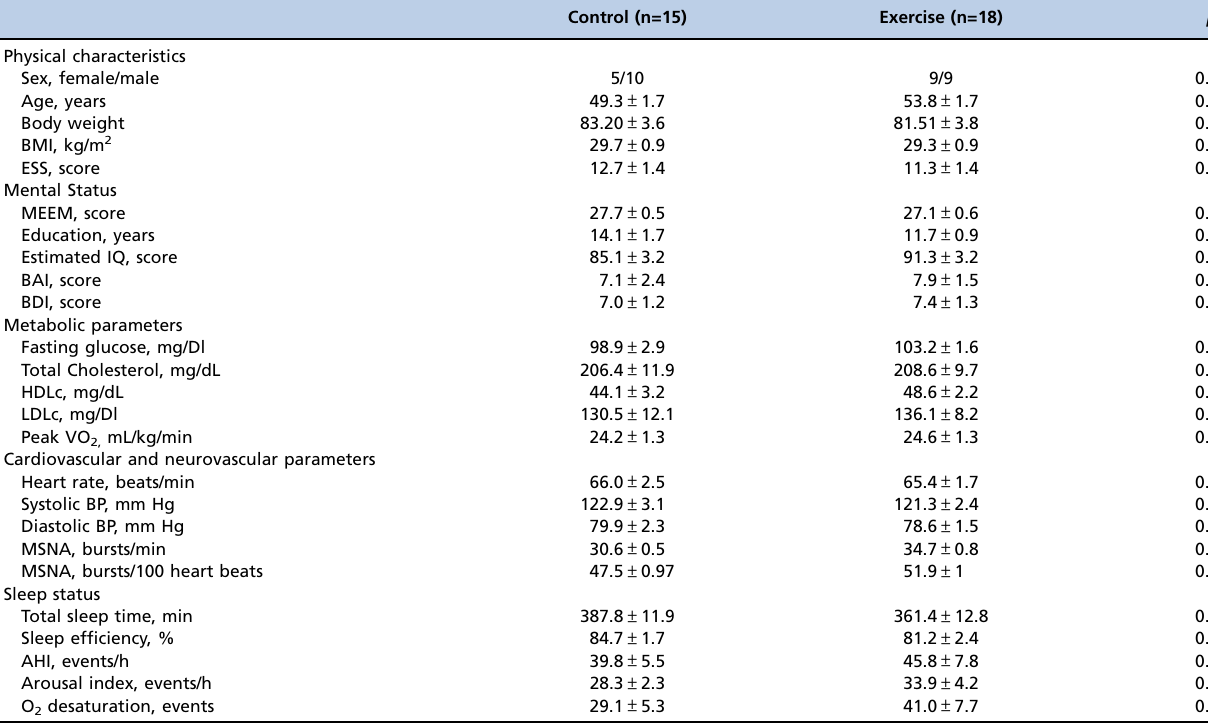
Control (n=15) Exercise (n=18) p